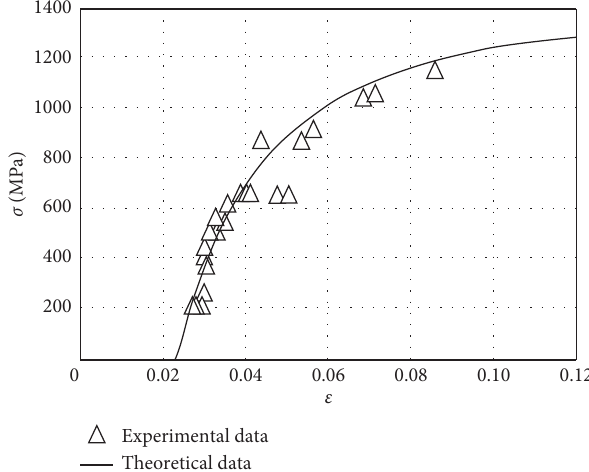
Figure 12: The dependence between the average value of micro- plastic deformation and the applied tensile stress in the deposited samples of steel 530H40 after thermoenhancement in mode III (group III).